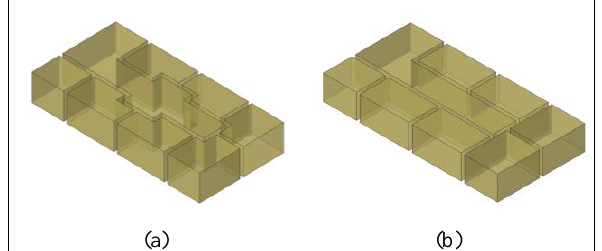
Figure 9. Final spaces of first floor (a) and second floor